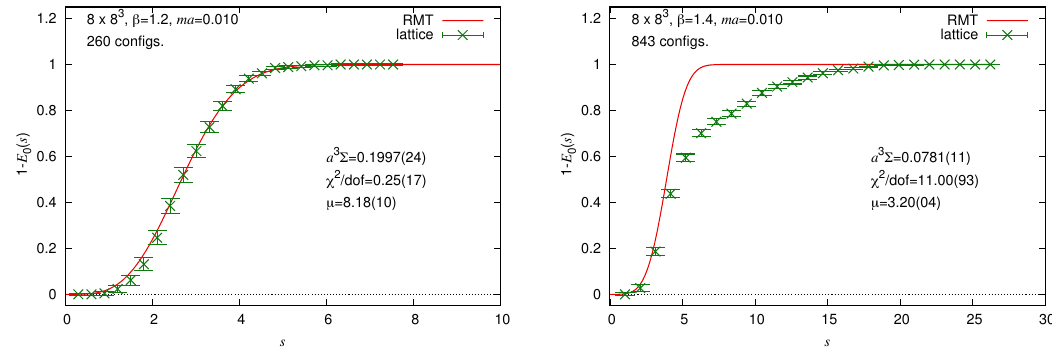
Figure 9 . Typical example of a good (cid:12)t (left) and a bad (cid:12)t (right). The horizontal scale for the RMT curve is determined by the the best value of the chiral condensate, which is denoted in the